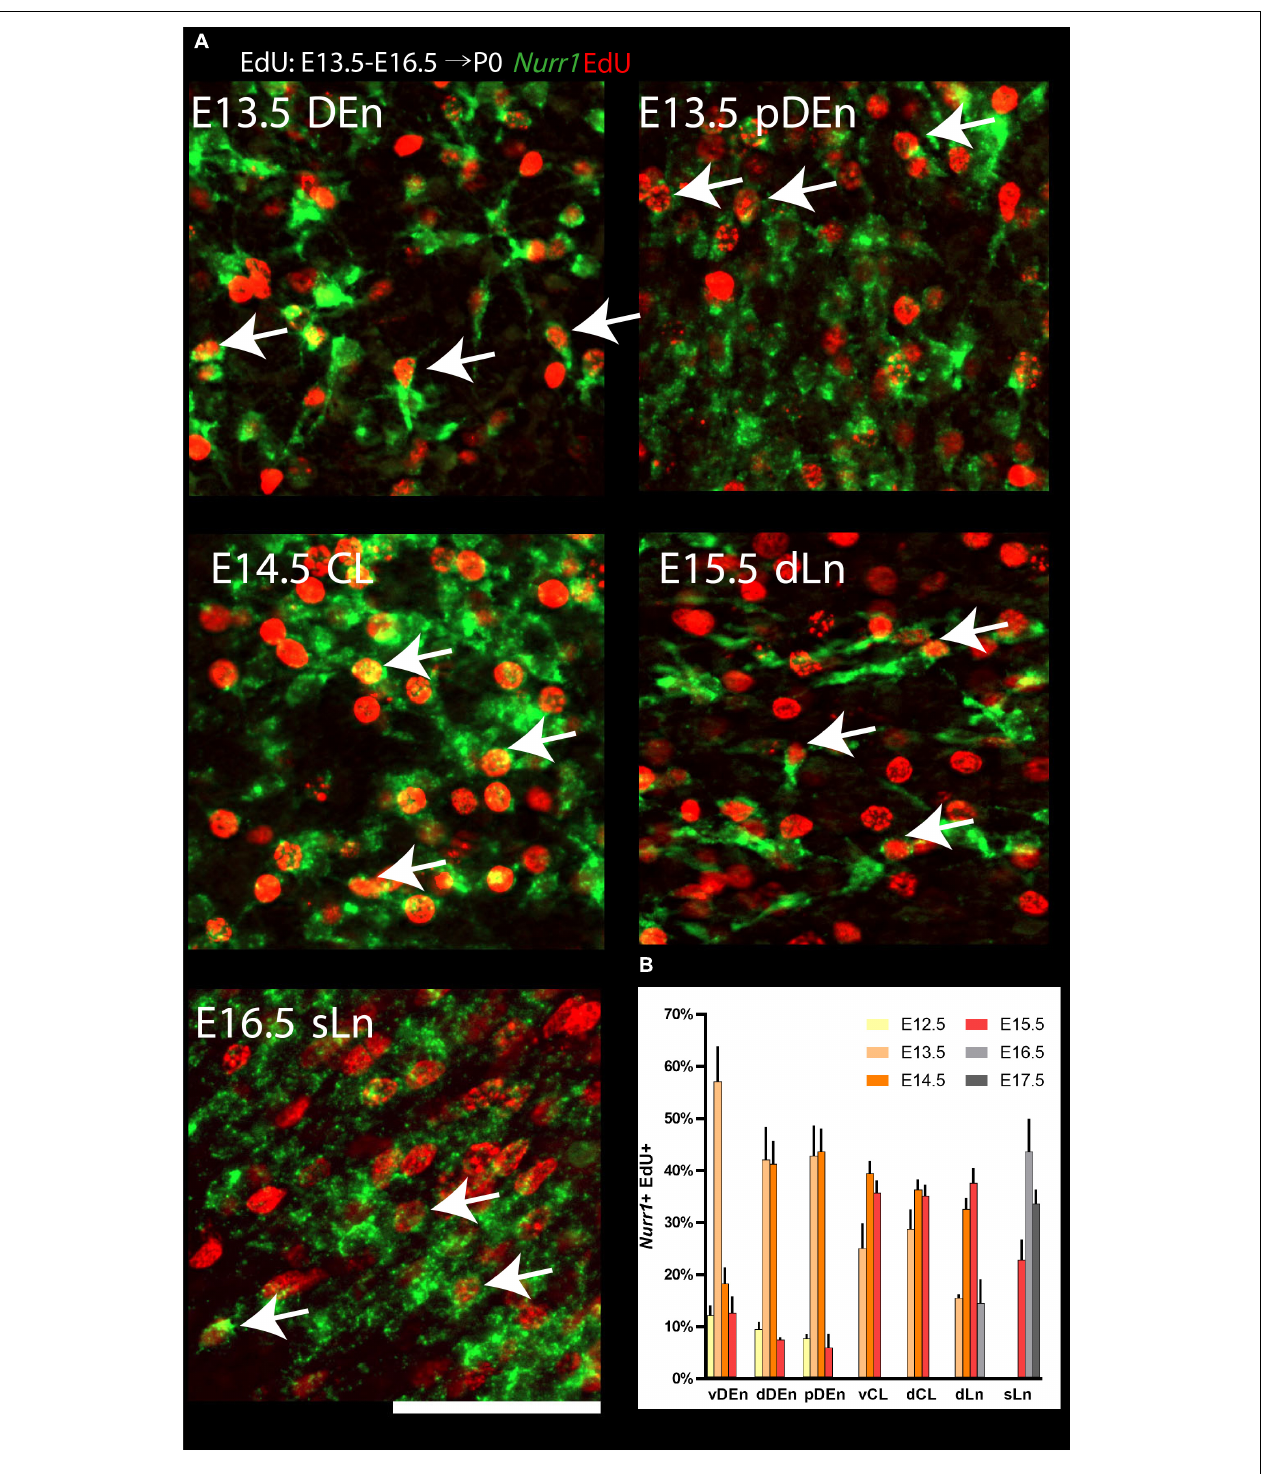
FIGURE 12 | Quantification of Nurr1 + EdU + double positive cells. (A) Examples of cell level overlapping of Nurr1 and EdU in all Nurr1 labeled claustrum regions, including DEn, pDEn, CL, dLn and sLn. (B) Quantification of Nurr1 + EdU + populations born at E12.5 to E17.5 in Nurr1 labeled regions including, dDEn, vDEn, pDEn, vCL, dCL, dLn, and sLn. Bars represent mean ± standard deviation. N = 3 brains for each date (3 sections from each brain). Scale bar in panel (A) = 100 µ m.